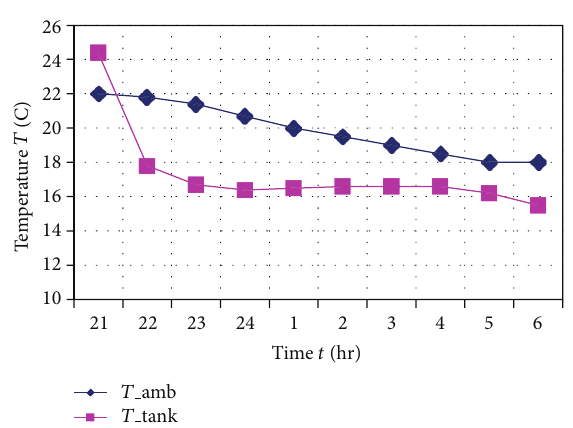
Figure 5: Water cooling with nocturnal cooling effect in Sydney using the system described in this work.